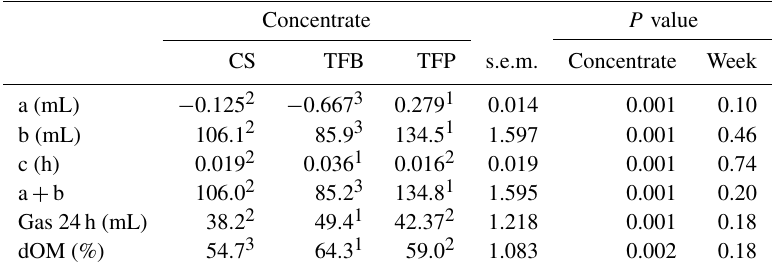
Table 3. Gas production (mL(300mgDM) − 1 ) and some estimated parameters of hay when incubated with different rumen fluid from ewes fed with different concentrate corn and soybean (CS), triticale and faba bean (TFB), and triticale and field pea (TFP). Concentrate